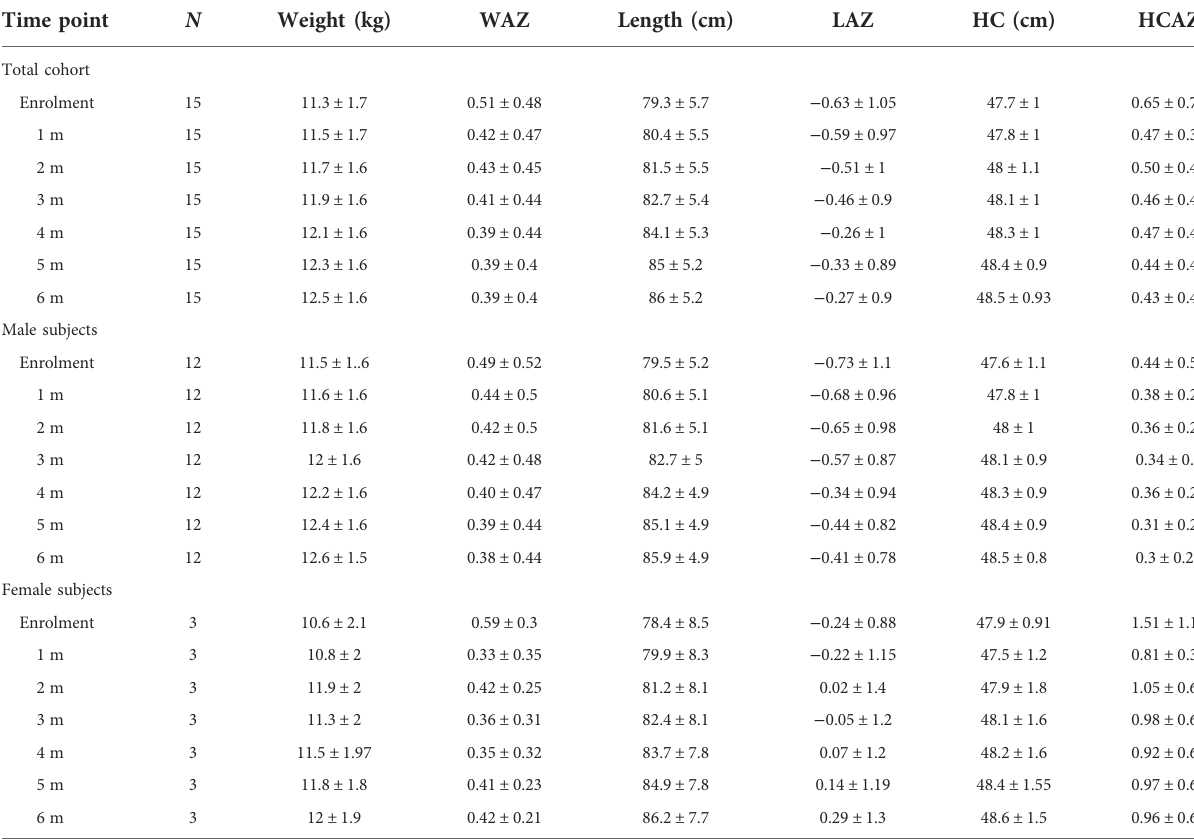
TABLE 2A Anthropometric measurements of subjects with cow ’ s milk allergy during the study. Time